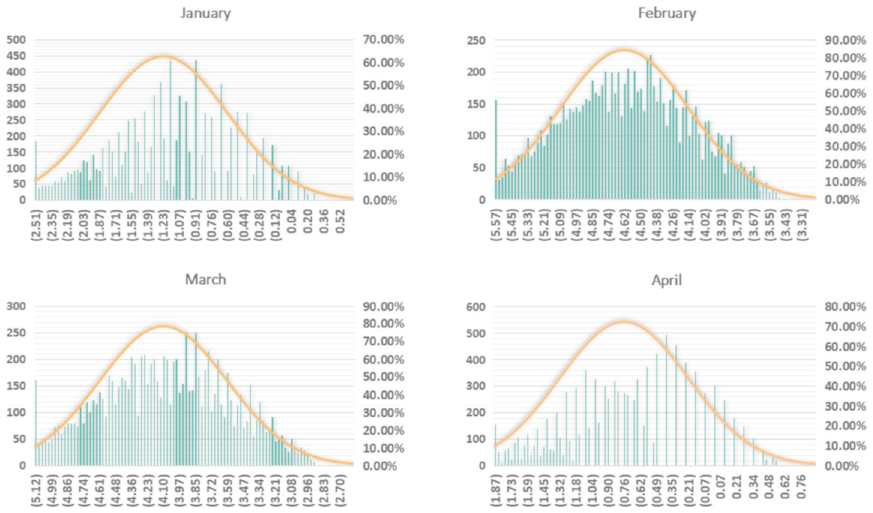
Figure 5. Probability distributions of the monthly CF changes of Hubei consumptive electric power from January through April in 2020, compared to the baseline year,